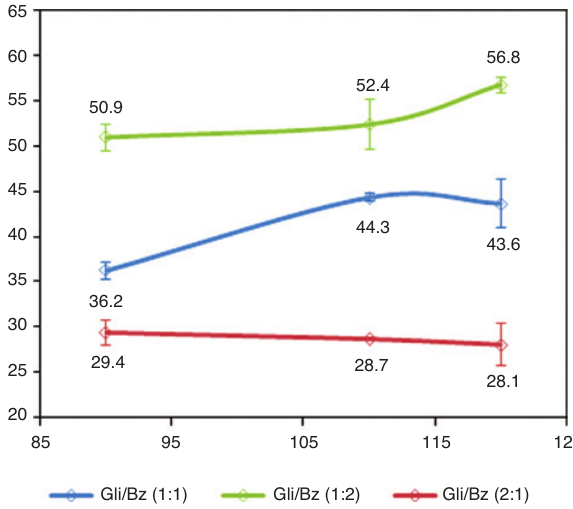
Figure 2: Reaction yields (%) versus different temperatures ( ° C) and reagents